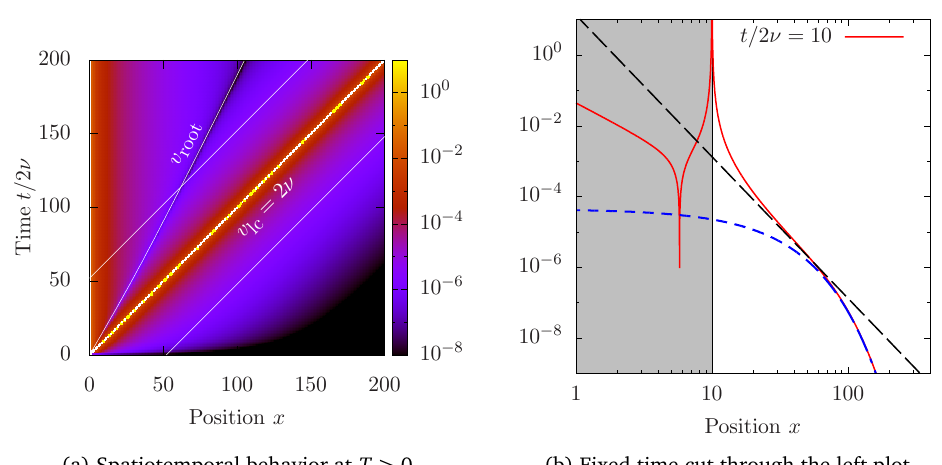
Figure 3: Spatiotemporal behavior of the equal-time anticommutator | C + ( x , t ) | for β = 30 as given by Eq. (22) without the intial contribution. The Fermi velocity is chosen such that ξ = β = 30. The signal on the diagonal is the light cone with (cid:112) an algebraic (power-law-like) decay for x < 3 ξ followed by an exponential decay. The algebraic regime is found between the white lines. A horizontal cut through the plot for time t / 2 ν = 10 is shown on the right (Fig. 3b) with both decay regimes. The black dashed line shows the algebraic regime as in the T = 0 case, whereas the blue dashed line represents the exponential decay given by Eq. (32). The size of the algebraic decay regimes shrinks with increasing temperature. The grey shaded area marks the inside of the light cone with a stationary algebraic correlation decay starting at x = 0. Due to different signs this contribution cancels the inner decay coming from the light cone leading to an inner structure with vanishing correlation at x (see text for root